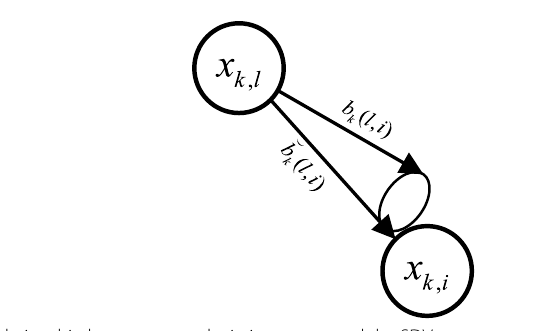
Fig. 3 The relationship between true deviation vector and the